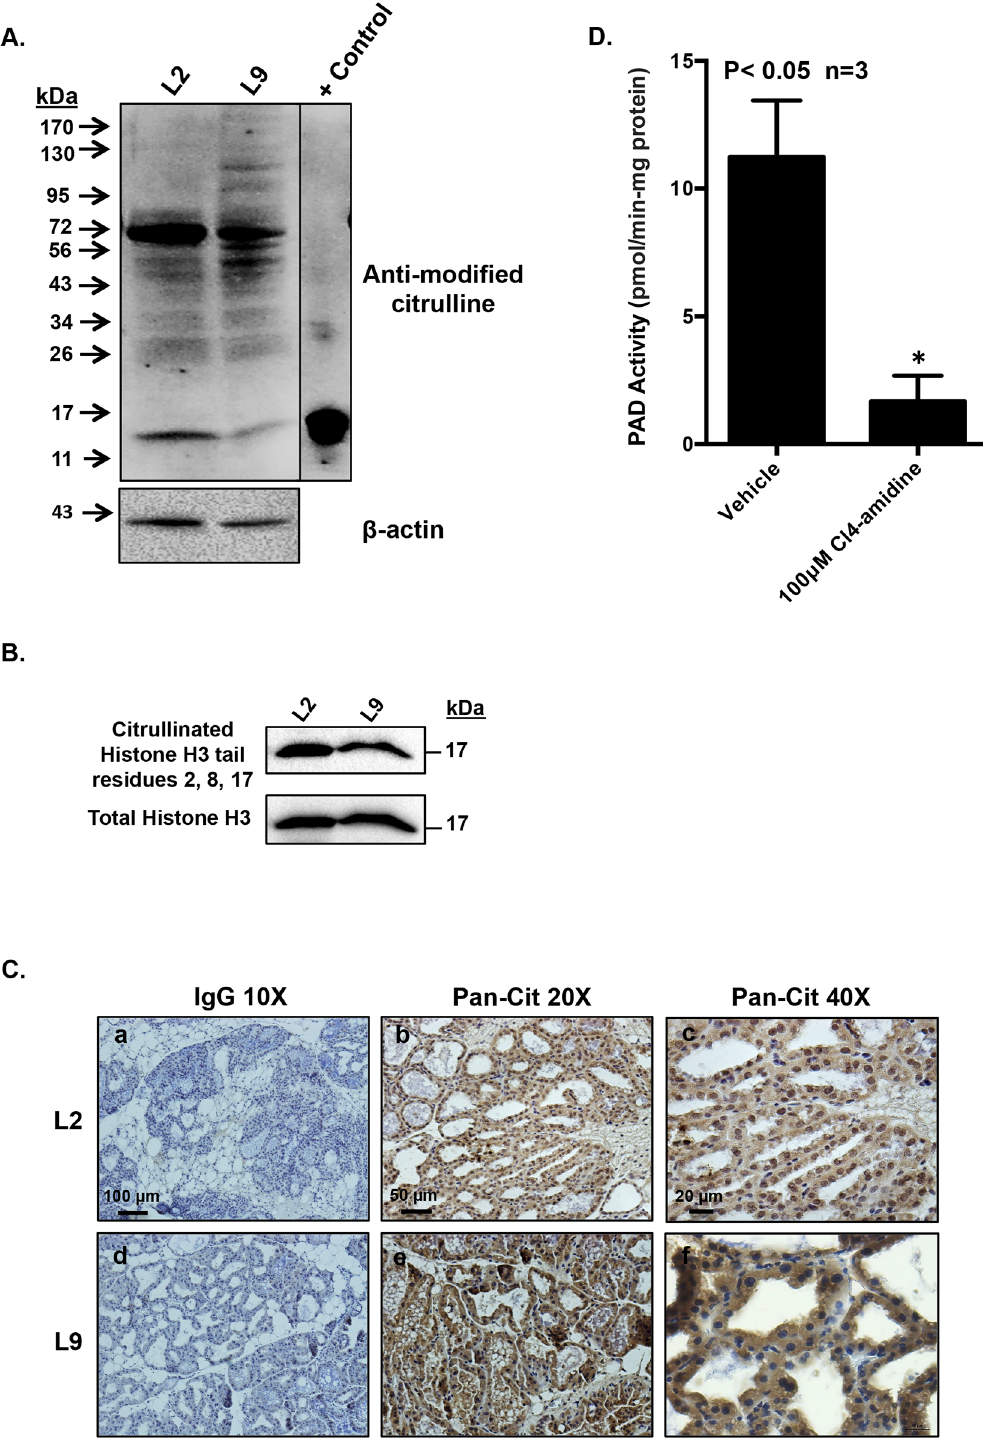
Fig 7. Citrullinated proteins are present in the lactating mammary gland and are citrullinated, in part, by PAD3. Mammary glands were collected on L2 and 9, homogenized and sonicated in modified RIPA buffer. (A) Citrullinated proteins are present in L2 and L9 mammary glands. Equal concentrations of protein lysates were examined by western blot following the AMC protocol. The positive control is in vitro citrullinated bulk histones. (B) Citrullinated histone tail arginine residues 2, 8, and 17 are present in L2 and L9 mammary glands. Equal concentrations of protein lysates were examined by western blot using an anti-citrullinated histone H3 arginine 2, 8, and 17 antibody. (C) Citrullinated proteins are detected in L2 and L9 mammary tissue. Mouse mammary tissue from